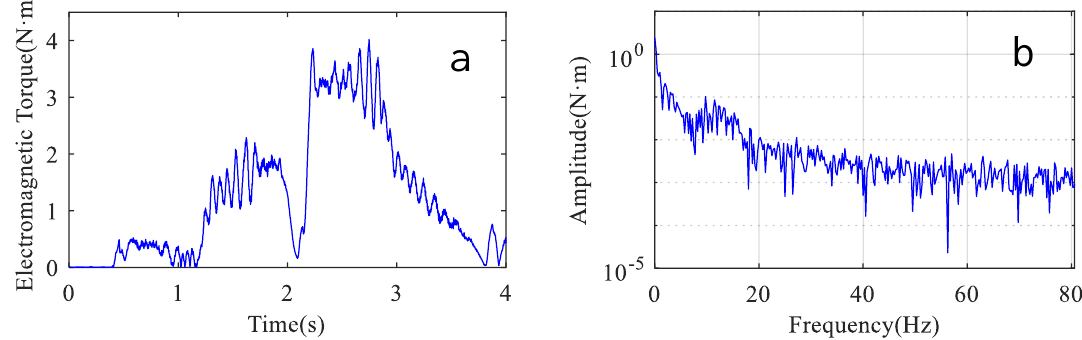
Figure 21. Motor electromagnetic torque. ( a ) waveform of the signal; ( b ) spectrum of the signal.